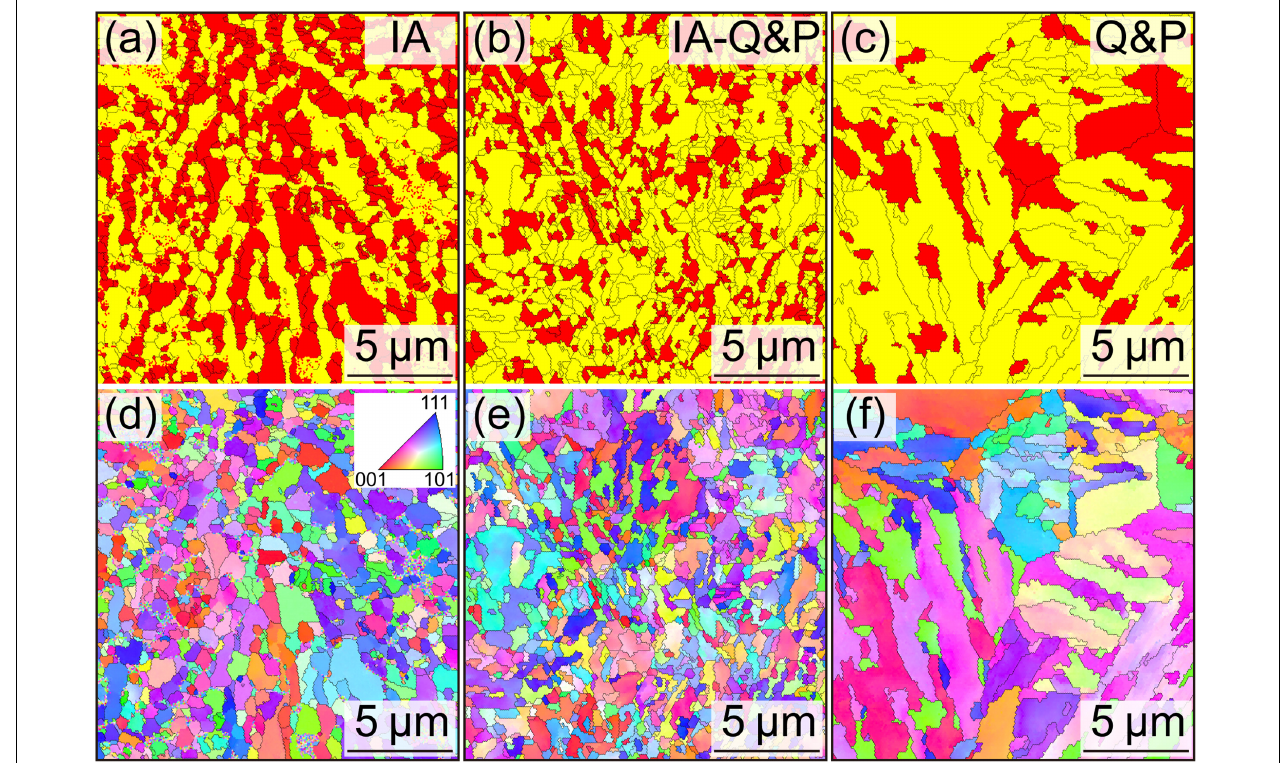
FIGURE 3 | EBSD phase maps and IPF maps of (a,d) IA, (b,e) IA-Q&P, and (c,f) Q&P steels, respectively.